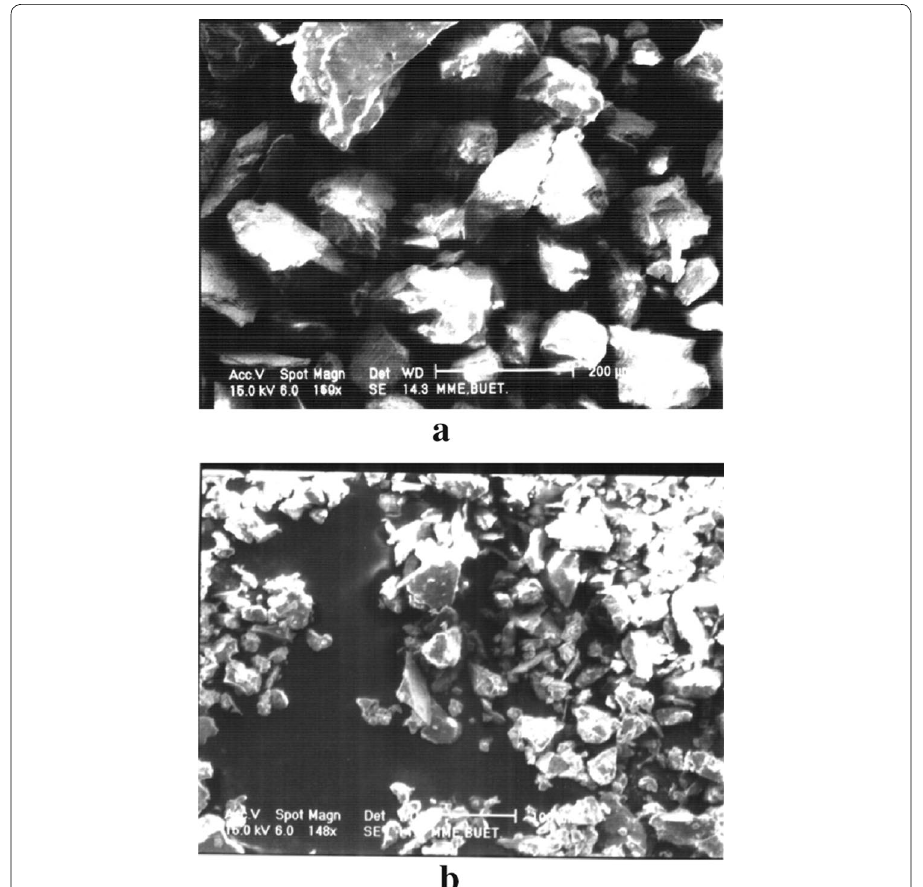
Fig. 3 Scanning electron microscopic view of ( a ) clean sand and ( Scale 200 µm), b pure silt used in this